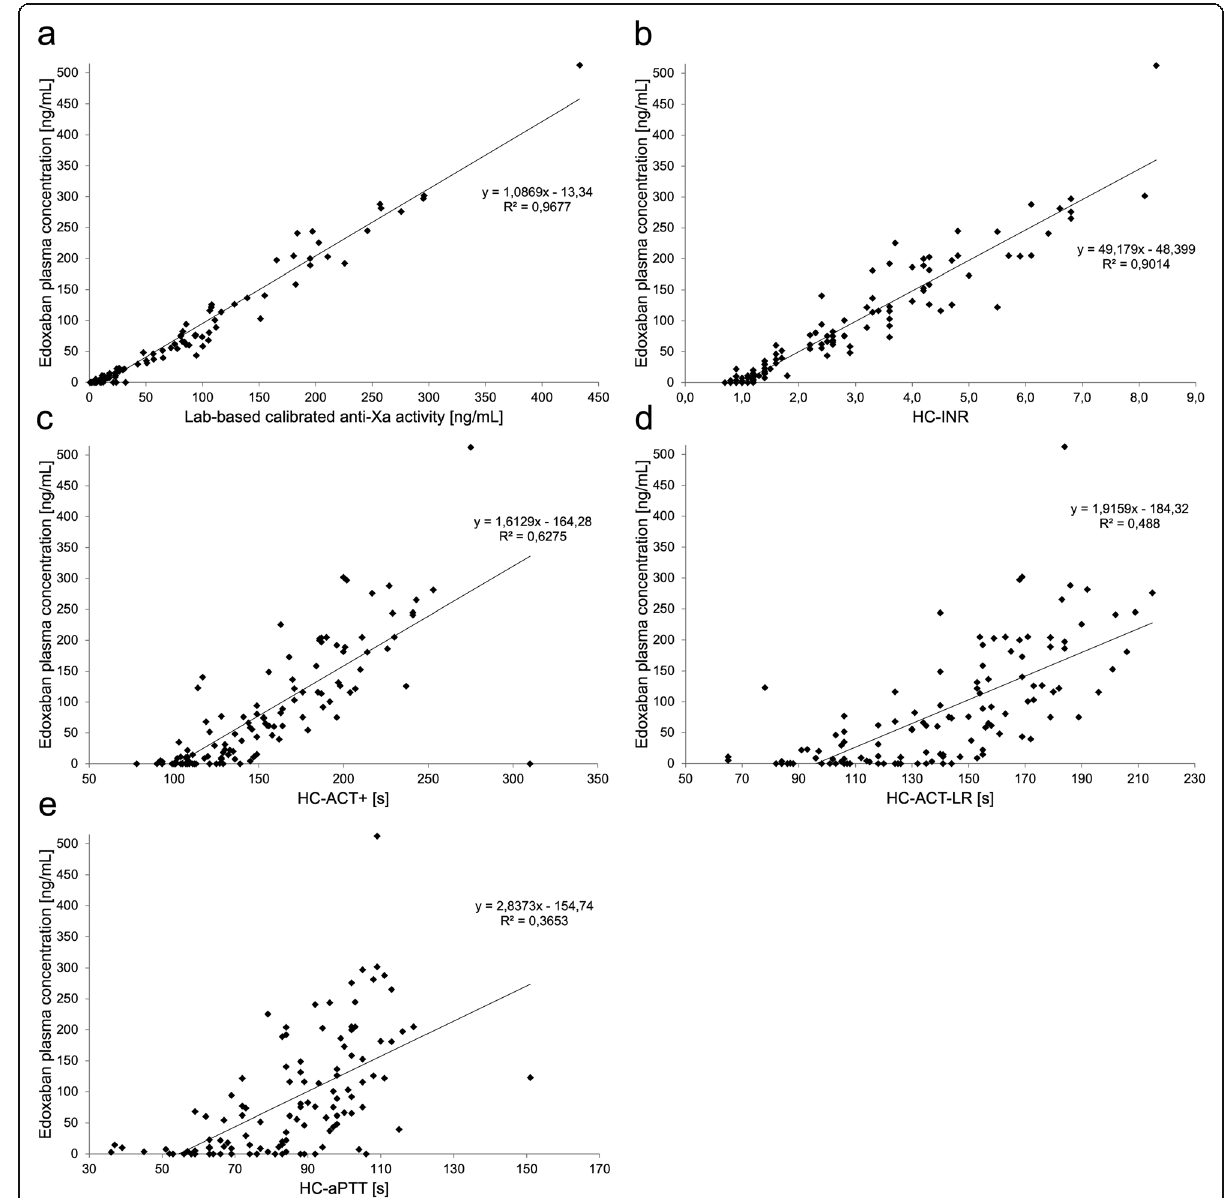
Fig. 1 Scatter plots visualizing the correlation of ( a ) laboratory-based calibrated anti-Xa activity and ( b to e ) the results of all four Hemochron ™